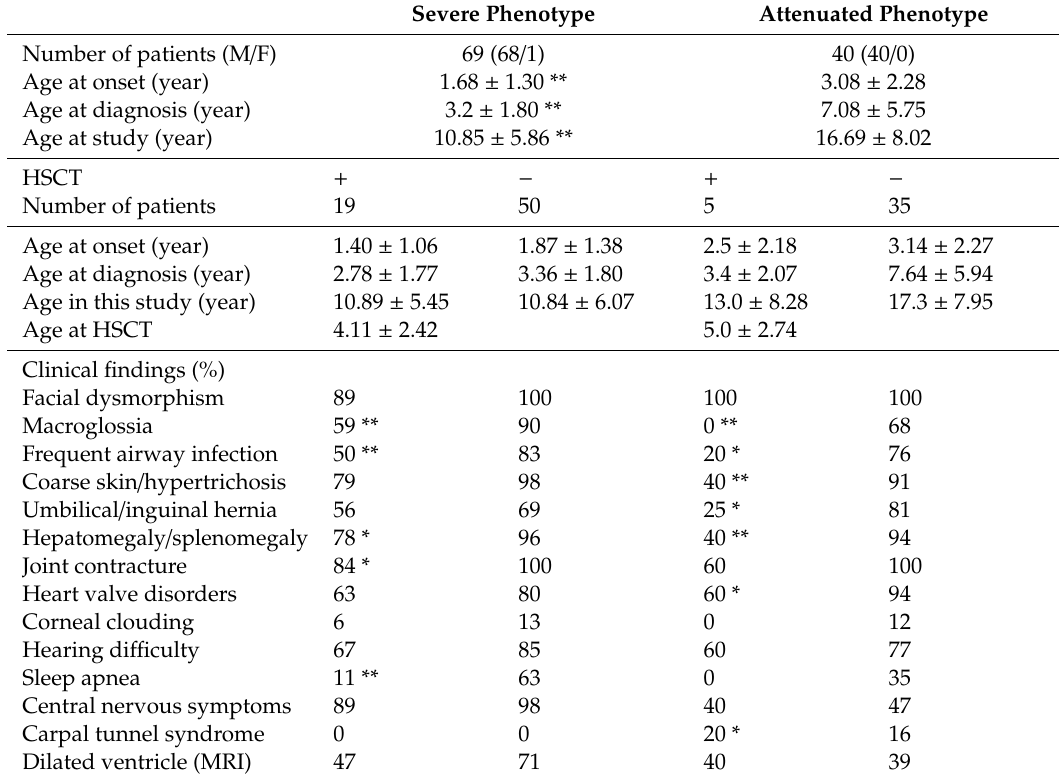
Table 1. Characteristics of patients with mucopolysaccharidosis (MPS II).